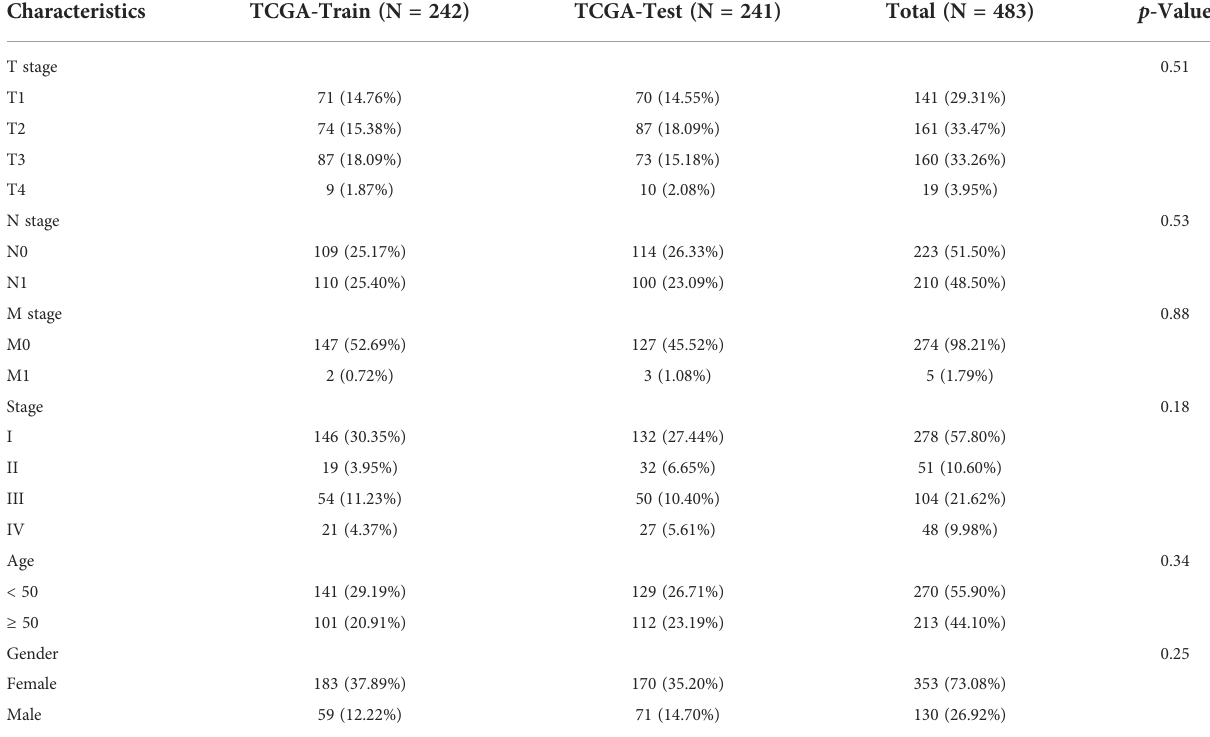
TABLE 4 Comparison of clinical data in of training set, test set, and the entire dataset. .